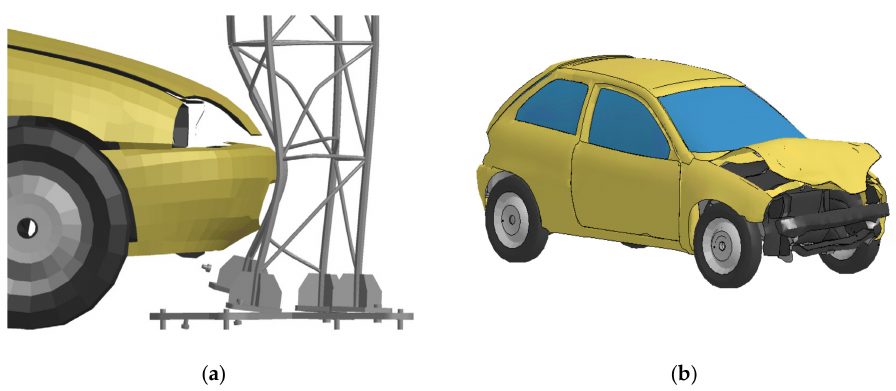
Figure 16. Numerical results Mast T03: ( a ) main bars deflection, ( b ) vehicle